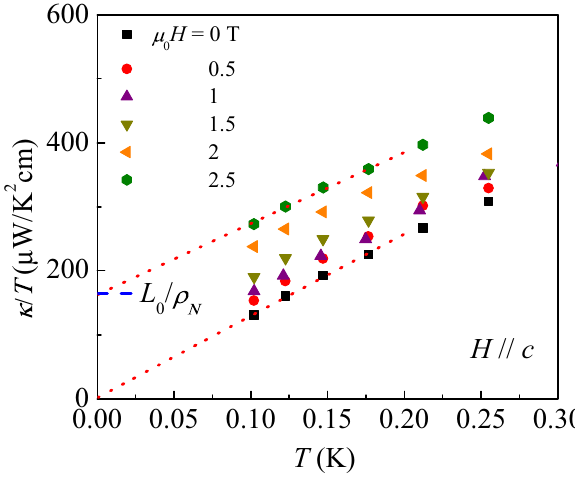
Figure 5. In-plane κ/ T of the 2H-Pd 0.08 TaSe 2 single crystal at various magnetic fields applied along the c -axis. The red dotted lines are the fitting curves of κ/ T below 200 mK. As the magnetic field reaches 2.5 T, which is comparable to µ 0 H the value expected from the Wiedemann–Franz law at the normal state, κ N / T dashed line). The magnetic field dependence of extracted κ 0 / T is summarized in Fig. 6.